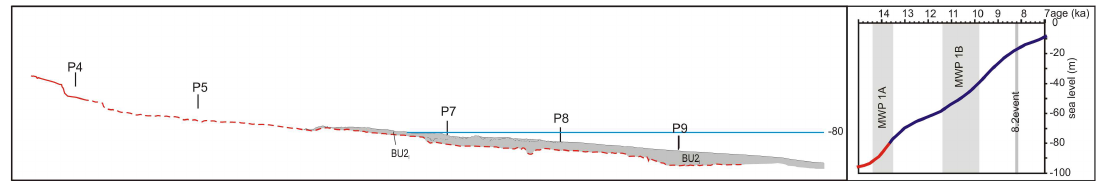
Figure 14. Alternative interpretation of unit A l considered the coastal part of the MIV and Ofanto depositional lobe